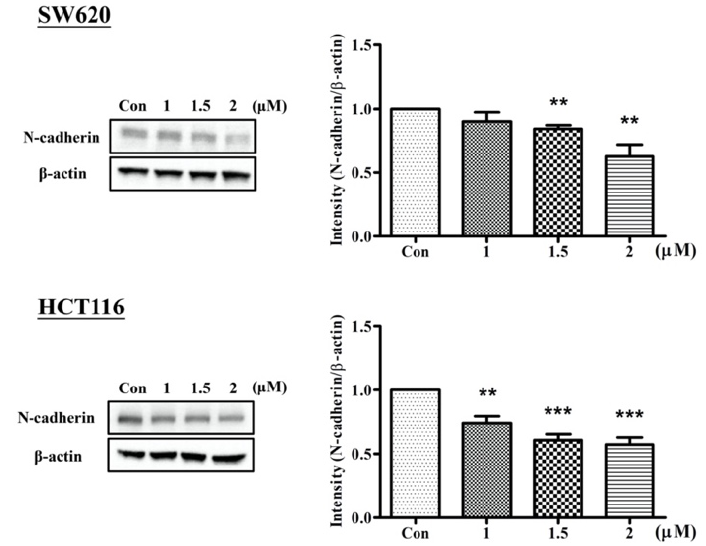
Figure 4. Western blot for N-cadherin, with β -actin-loading control, in SW620 and HCT116 cells treated with Arylquin 1; quantitative data are expressed as mean ± SEM; ** p < 0.01 and *** p < 0.001 compared to the control group.